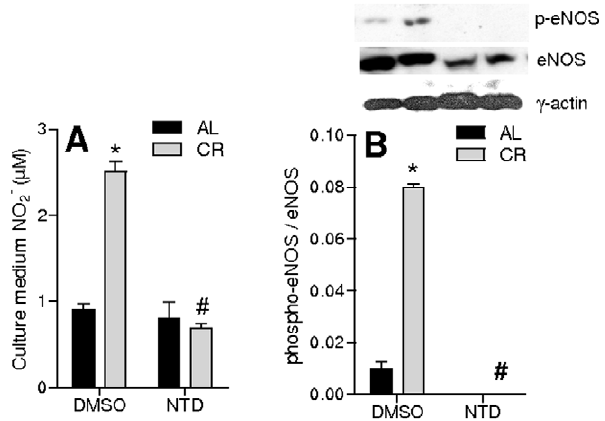
Figure 3. CR-induced NO 2 2 release is dependent on Akt activity. ( A ) NO 2 2 levels in the culture medium from VSMC incubated 24 h with AL or CR serum and 0.001% DMSO (solvent control) or 1 m M NTD. ( B ) eNOS Ser1177 phosphorylation in homogenates from VSMC incubated 24 h with AL or CR serum and 0.001% DMSO or 1 m M NTD. *p , 0.05 versus AL; # p , 0.05 versus DMSO. Representative blots are shown above quantifications.